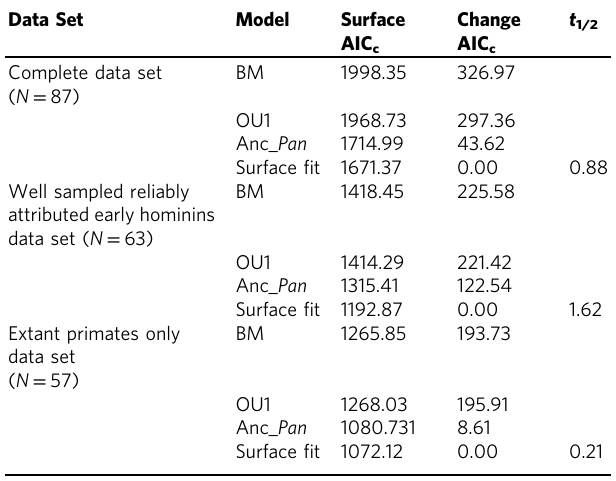
Table 3 AIC c results and comparison between models for different evolutionary hypotheses including Brownian motion (BM), a single regime OU model (OU1), a chimpanzee-sized ancestor of all hominoids (Anc_ Pan ), and the best-supported model (Surface fi t) for different subsets of body mass